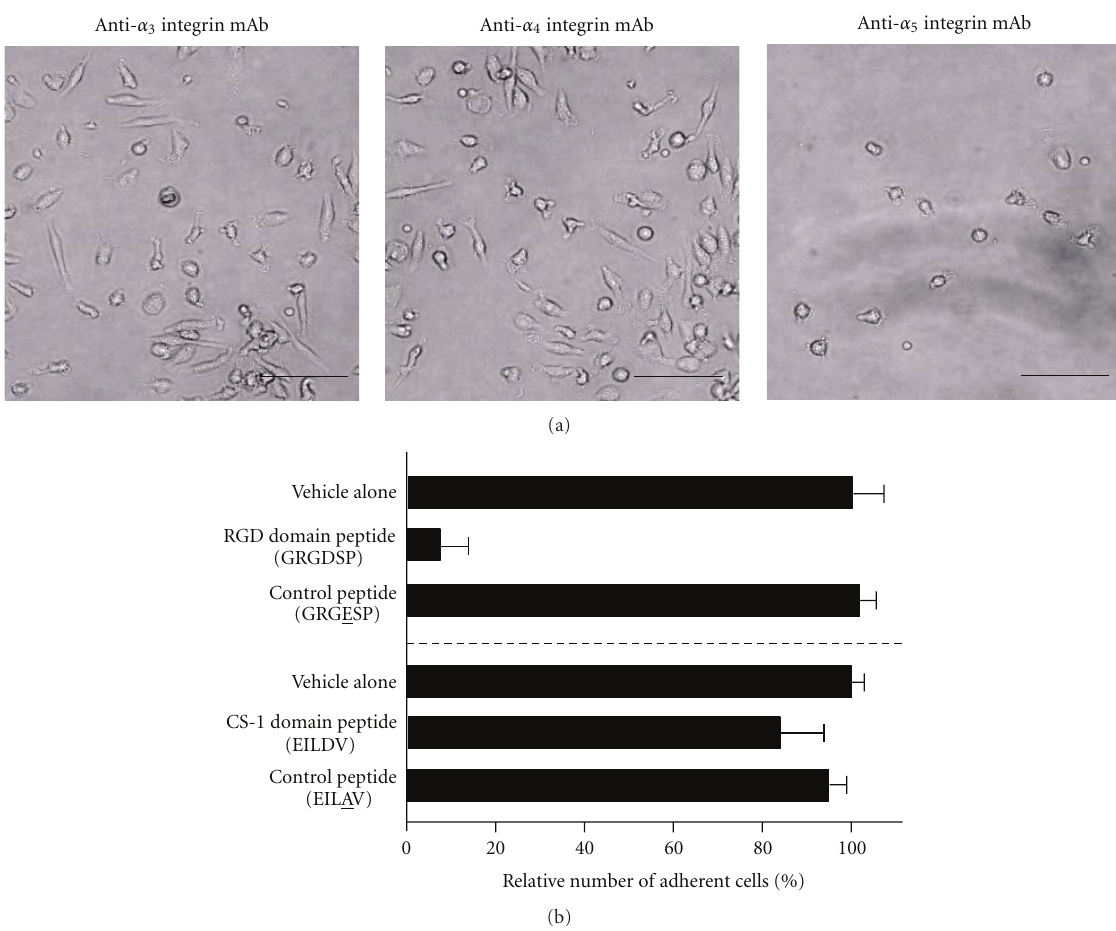
Figure 4: E ff ects of anti- α integrin mAb, RGD domain peptide, or CS-1 domain peptide on MOMC generation. (a) MACS-sorted CD14 + monocytes (4 × 10 5 ) were cultured with CD14 − PBMC-conditioned medium on 24-well plastic plates coated with fibronectin (Sigma) for 7 days. Anti- α 3 integrin, anti- α 4 integrin, or anti- α 5 integrin mAb was added at the initiation of cultures and added again every other day. The medium containing floating cells was exchanged with fresh medium at day 3. Adherent cells were observed with an inverted microscope. Bars: 100 μ m. (b) An RGD domain peptide (GRGDSP) or its corresponding control peptide (GRGESP) or a CS-1 domain peptide (EILDV) or its corresponding control peptide (EILAV) was added at the initiation of cultures and added again every other day. The number of adherent cells obtained at day 7 was counted. The results are expressed as proportion of the number of adherent cells in individual cultures to the number of adherent cells in the control culture without peptide or vehicle. The results shown are the mean and standard deviation of 3 independent